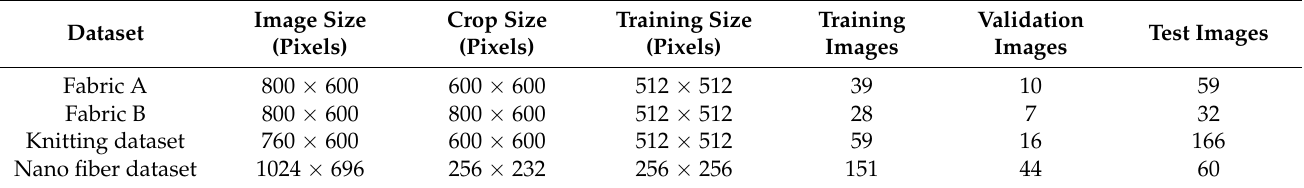
Table 1. Summary of defect